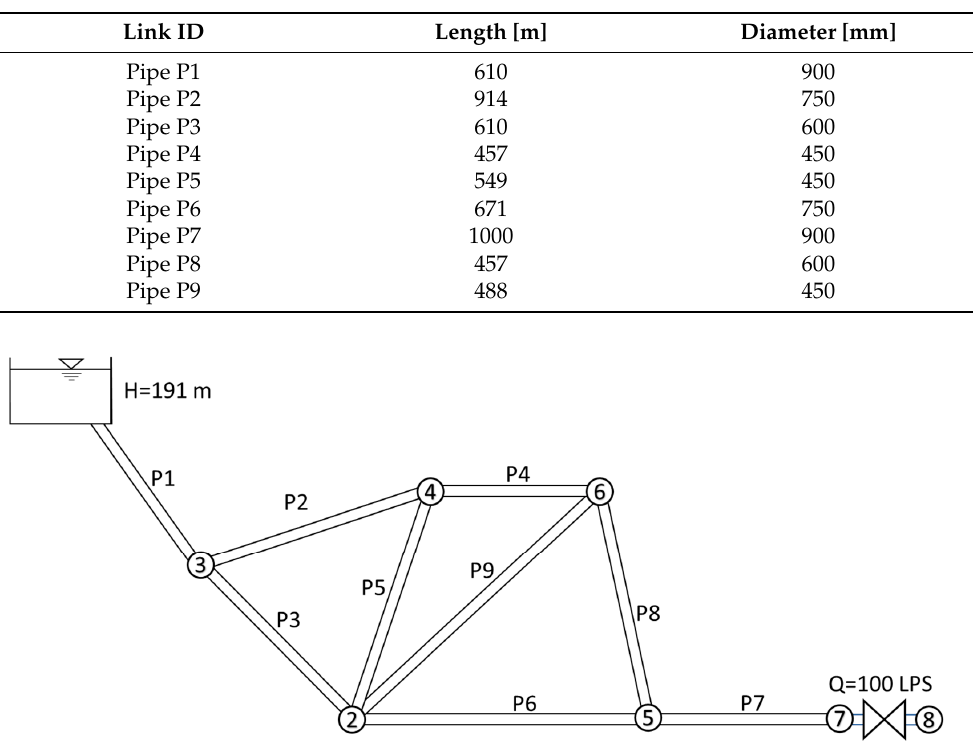
Table 1. The pipes case study 02.